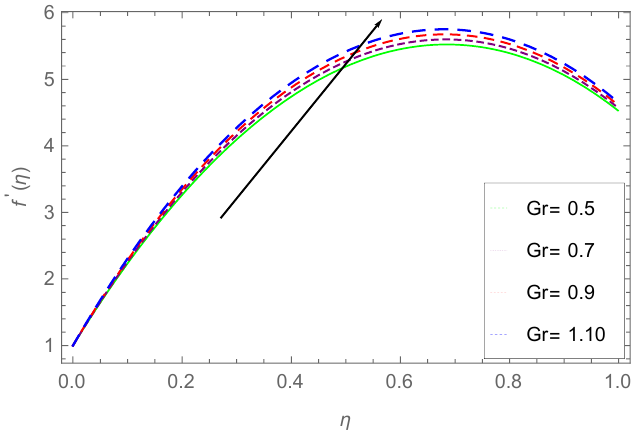
Figure 6. Impact of Gr on f (cid:48) ( η ) , for γ 1 = 0.4, β = 0.6, St = 0.5, Gm = 0.8, M = 0.7.